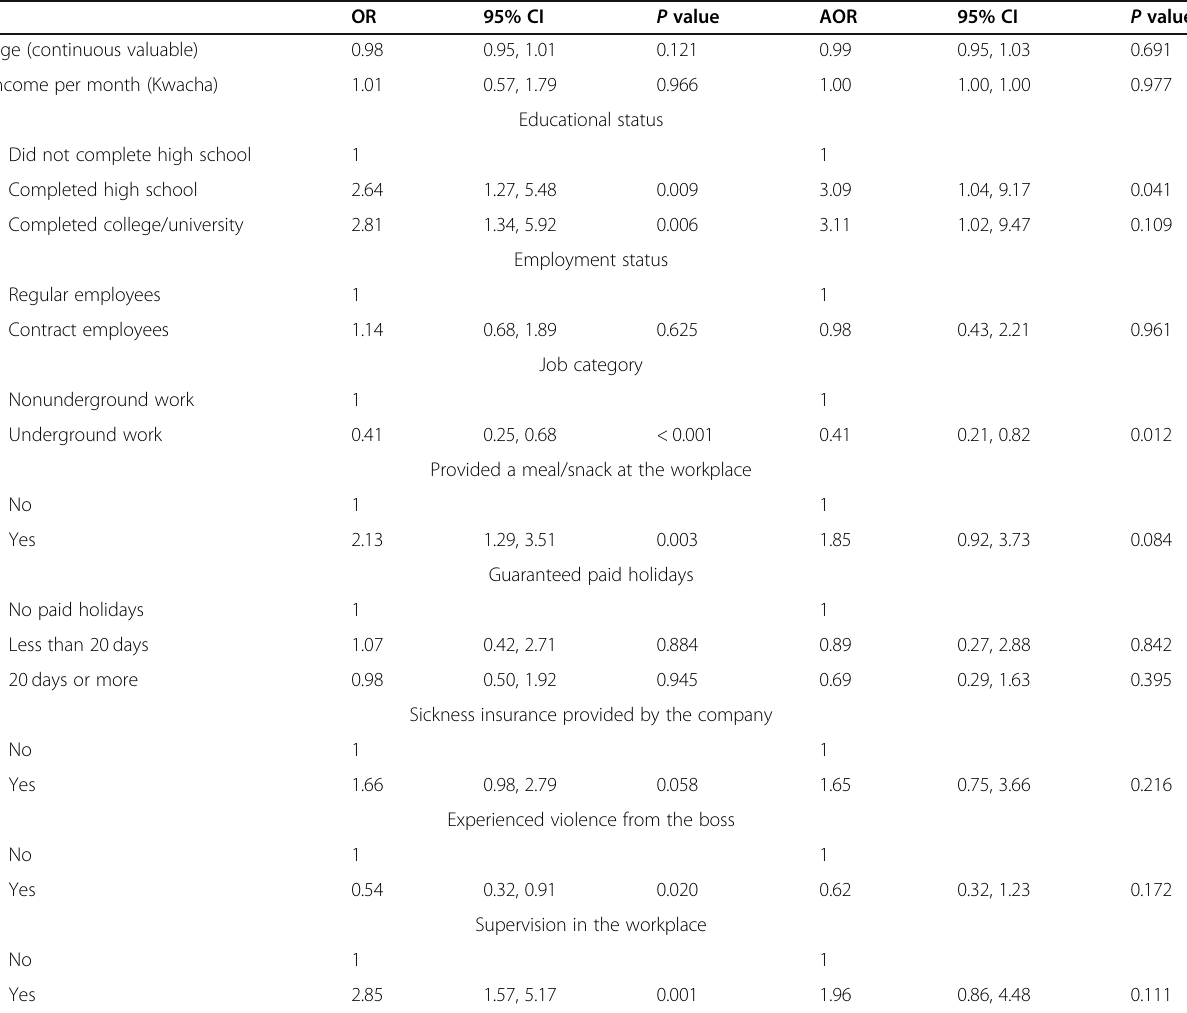
Table 5 Factors associated with self-rated health among mineworkers